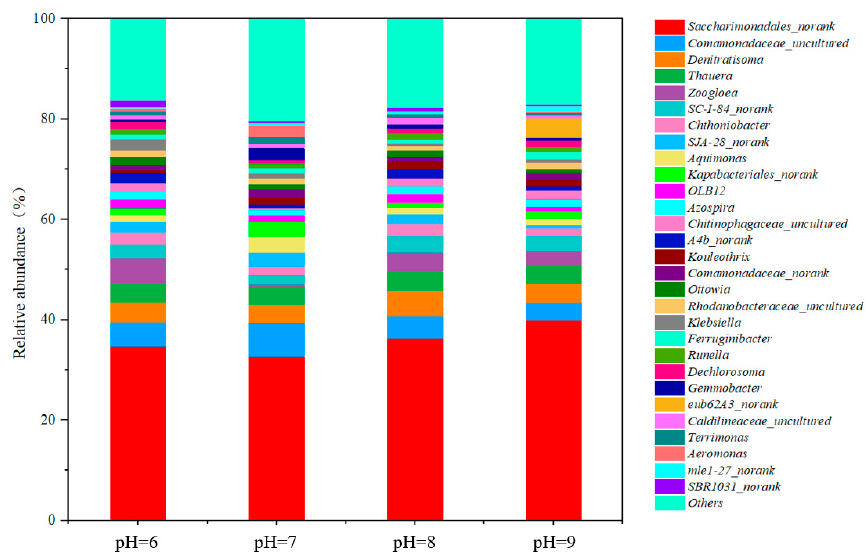
Figure 7. Microbial community structure of biofilm under different influent pH (genus level).